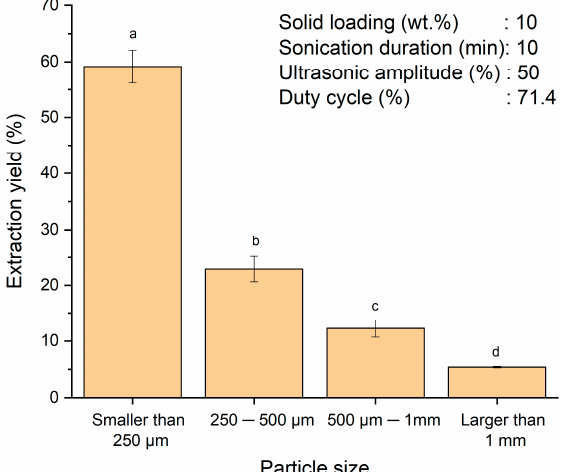
Figure 1. Effect of various particle sizes of SPW (smaller than 250 µ m, 250–500 µ m, 500 µ m–1 mm and larger than 1 mm) on extraction yield of starch from SPW. Different letters indicate the values are significantly different ( p < 0.05).